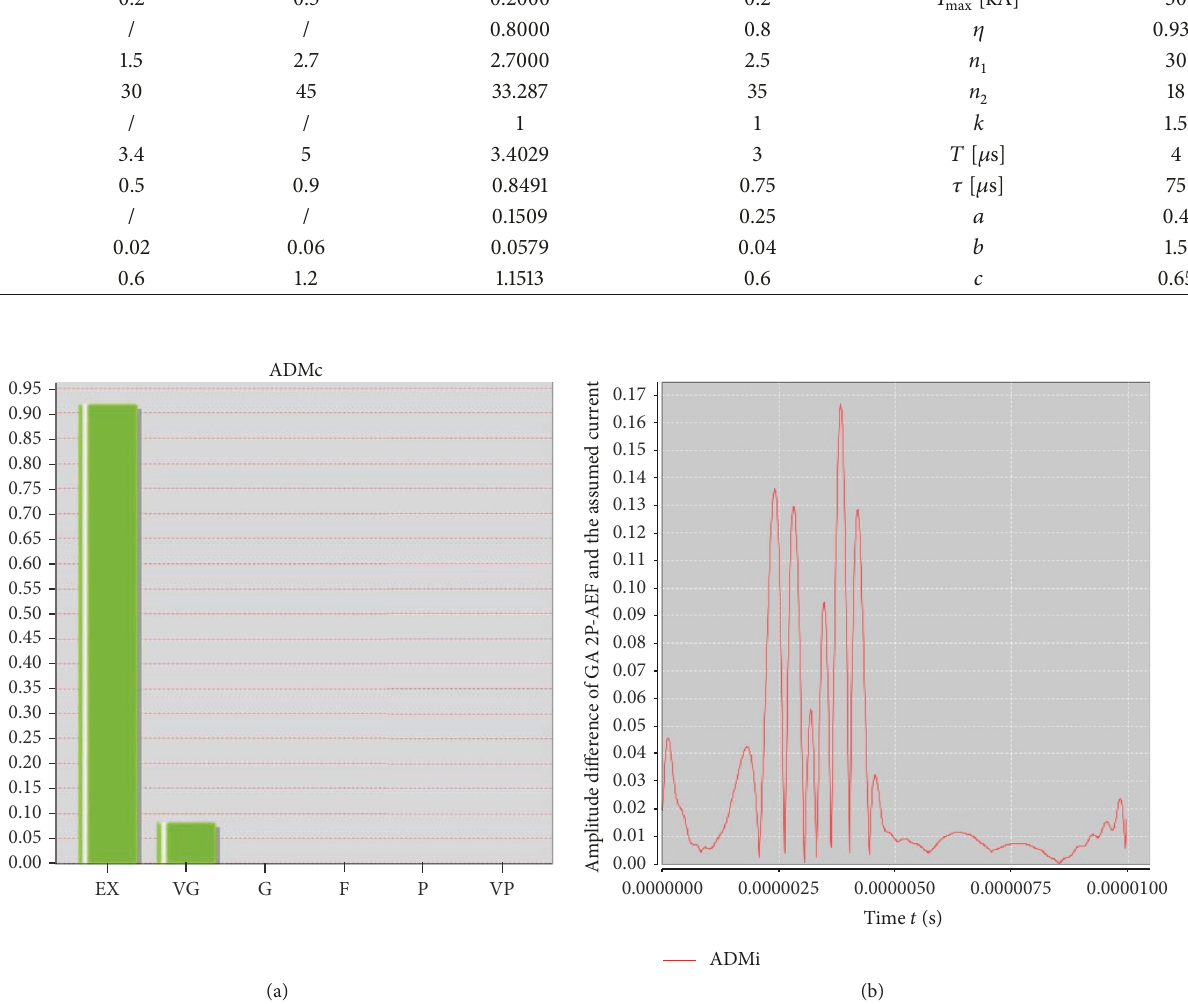
Figure 4: (a) ADMc and (b) ADMi obtained by FSV applied to the assumed current from [27] and its approximation by 2P-AEF(2,1,2) using GA for parameters